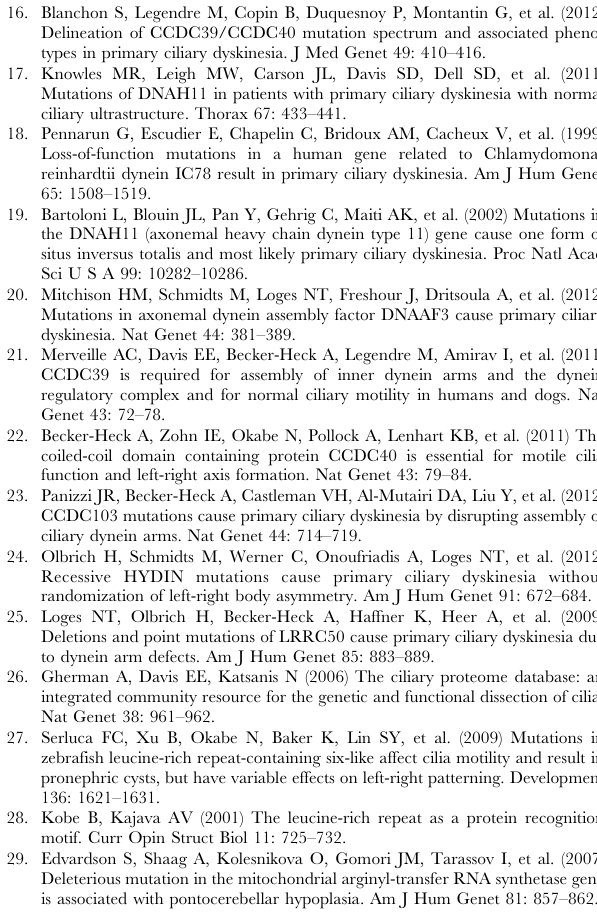
Figure S1 Co-localization of LRRC6 with different organelles. Immunofluorescent staining of tracheobronchial epithelial cells from healthy subject showing no co-localization of LRRC6 (red) with markers of endosomes (green), and lysosomes (green). However, LRRC6 localized with x -tubulin, a marker for basal bodies (green). Nuclei were stained using DAPI (blue). acetylated a -tubulin, a cilia marker, is shown in turquoise (scale bar = 10 m m). Figure S2 RT PCR analysis of LRRC6 expression in RNAi silenced cells. (A) LRRC6 expression in LRRC6-specific shRNA transfected airway epithelial cells (B) Immunoblot analyses of airway epithelial cells transfected with three different LRRC6 -specific shRNA or non-targeted shRNA (NT) sequences and nontransfected control cells (M). (C) En face images of LRRC6 in cultured preparations of ciliated airway epithelial cells from a normal donor, transfected with either non-targeted, control shRNA (NT) or different LRRC6 targeted shRNA sequences. LRRC6 (red), acetylated a -tubulin (green), a ciliated cell marker, and co-stained with DAPI (blue). (scale bar = 20 m m).